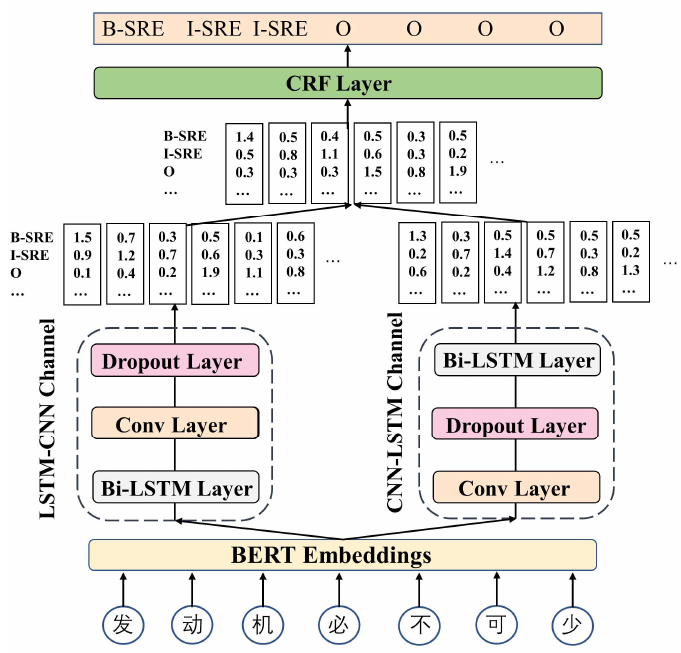
Figure 4. Input example for the model (The input was Chinese data).